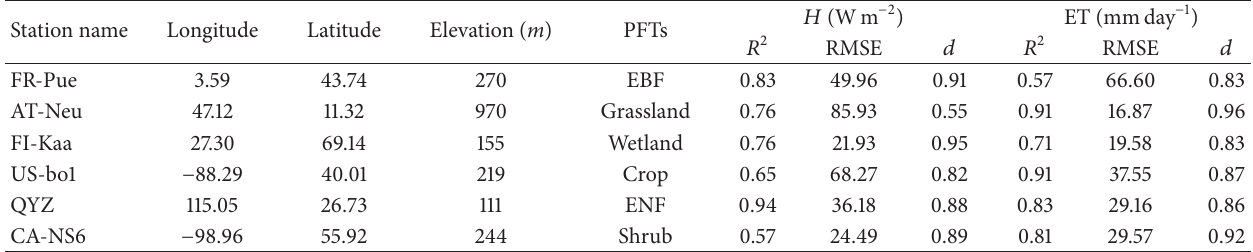
Table 1: EASS validation results for 𝐻 and ET for several typical